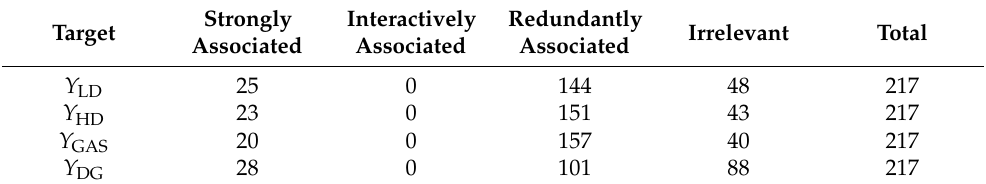
Table 5. Variable differentiation results.